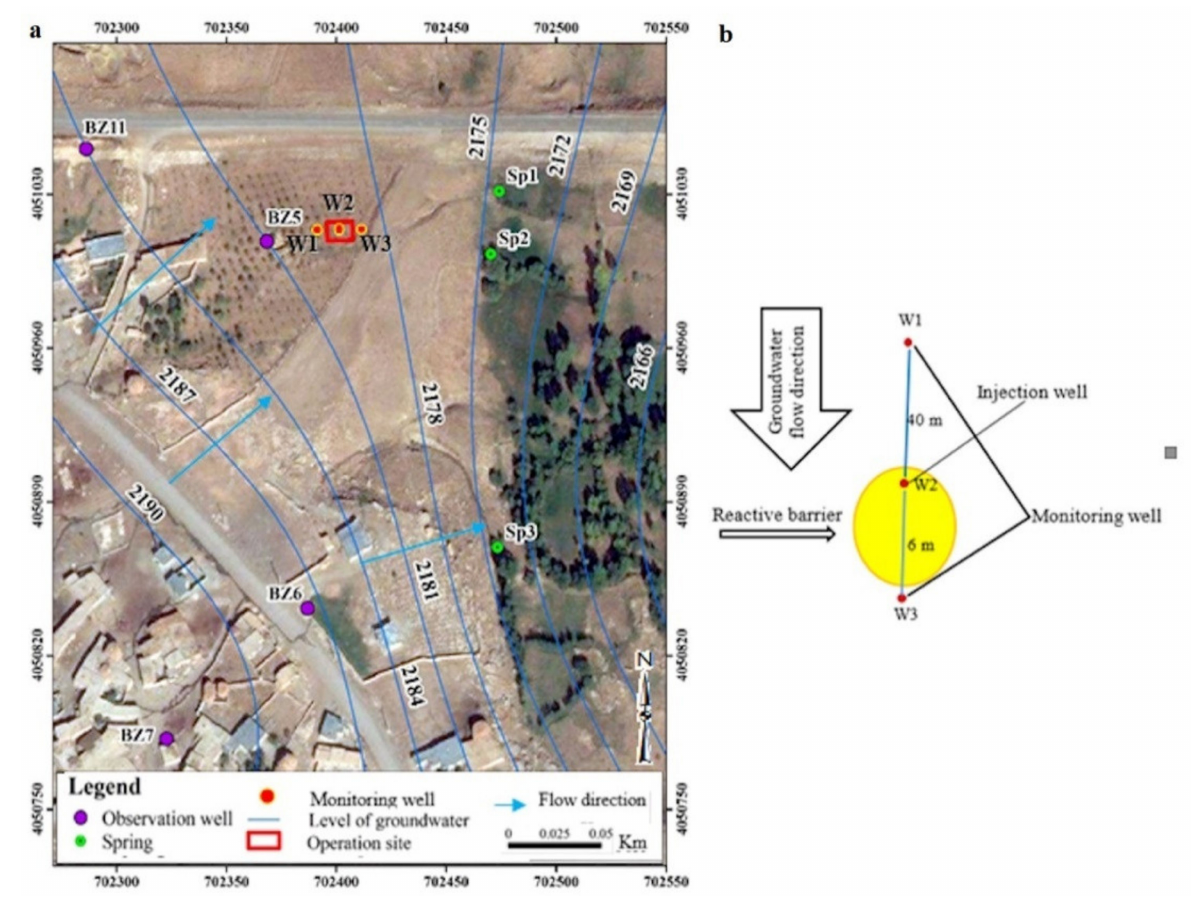
Figure 1. Top view of ( a ) the groundwater flow direction map of the site, and ( b ) the location of injection well and monitoring well in the testing area. The testing area is marked by the red square in the top part of Figure 1A. The springs are shown in green, and available observation wells are in red.